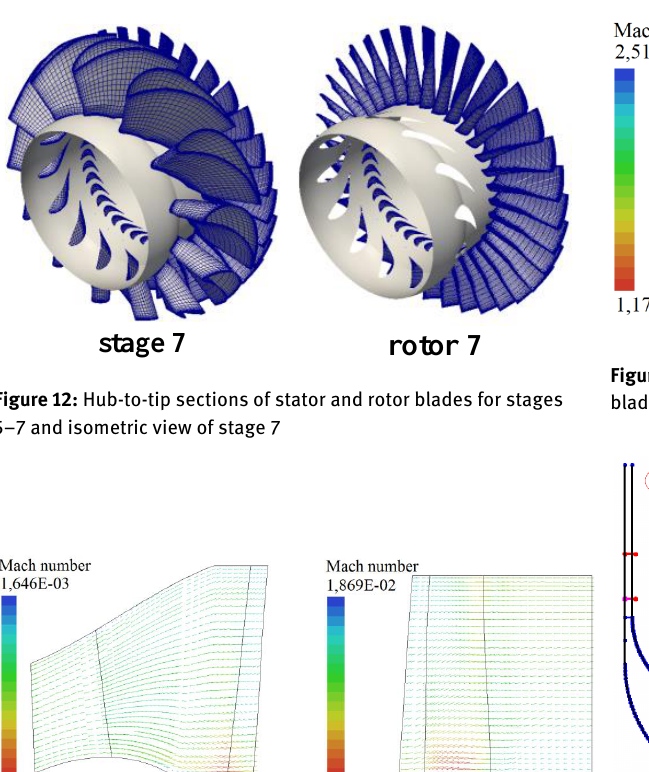
Figure 13. Velocity vectors colored by Mach number in a meridional section at the mid blade-to-blade distance of stage 7